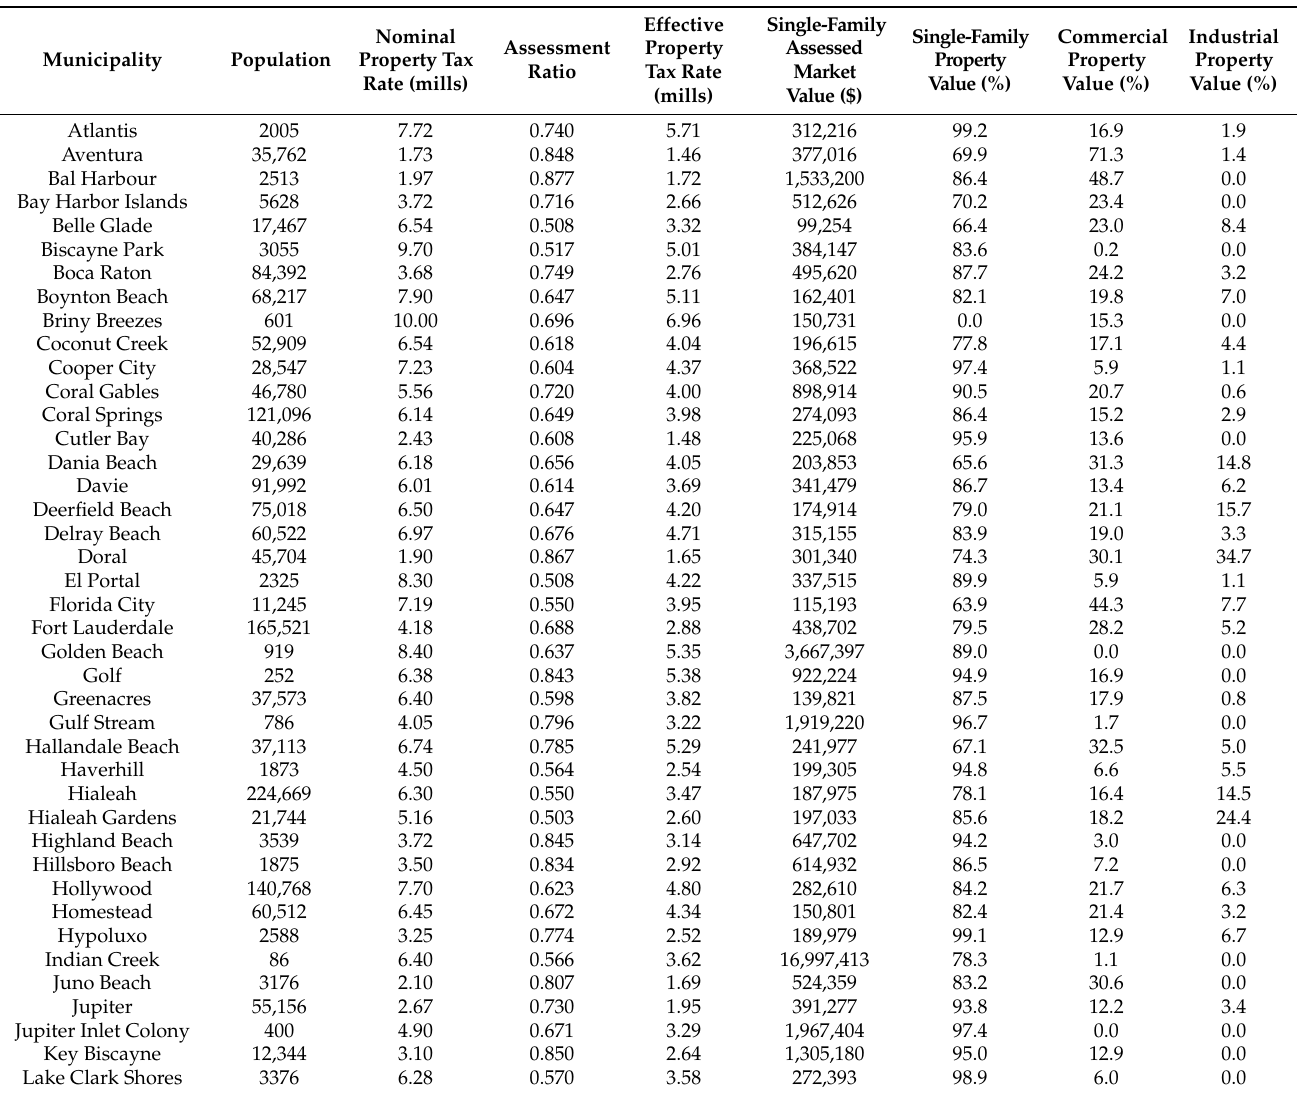
Table A1. Selected statistics by